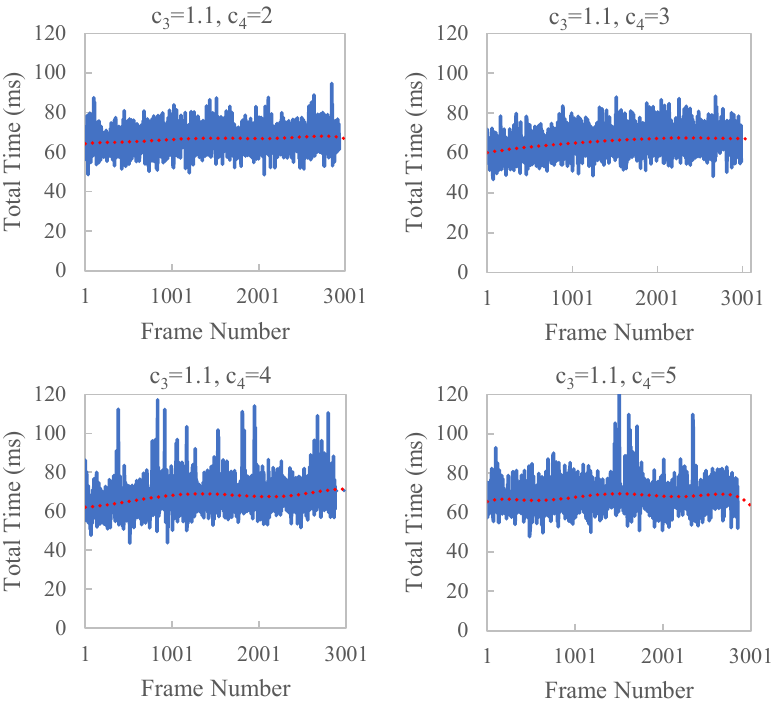
Figure 11. Time efficiency of reconstruction KITTI odometry sequence 00 with different c 4 . When c 4 is larger than 3, large jitters in the running time occasionally